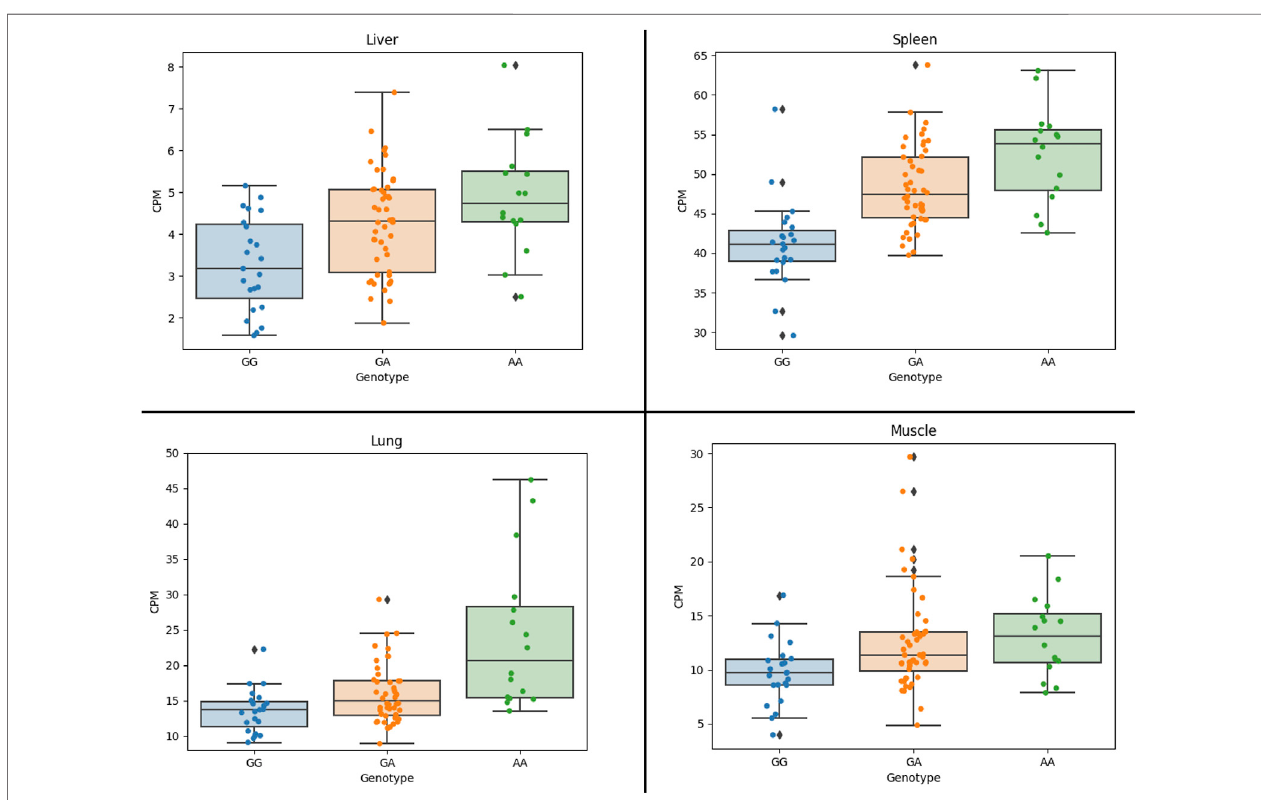
FIGURE3| AssociationofCCND2expressionwiththeleadSNPinfour87crossbredindividuals(4tissues).FigureshowsCCND2expressionindifferentgenotype classes. G allele is associated with more fat, while the A allele is associated with faster growth. Figure shows that the A allele is signi fi cantly associated with